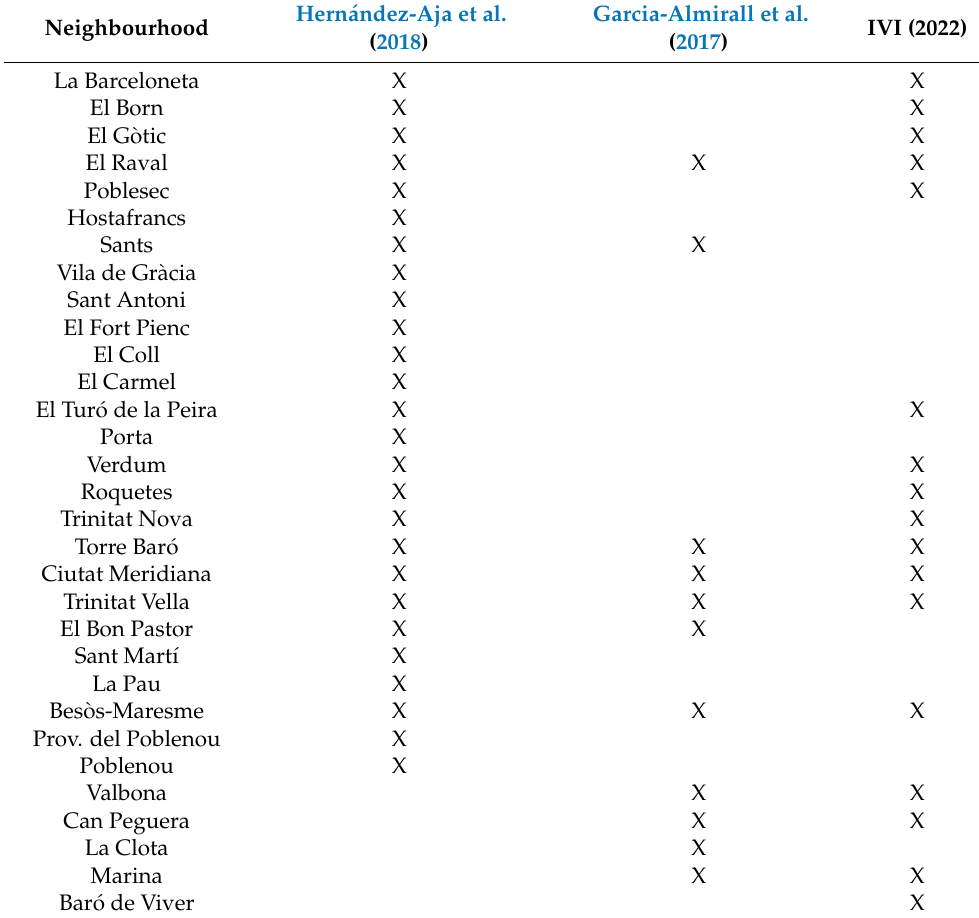
Table 5. Cross-checking results obtained from the IVI with earlier indices.